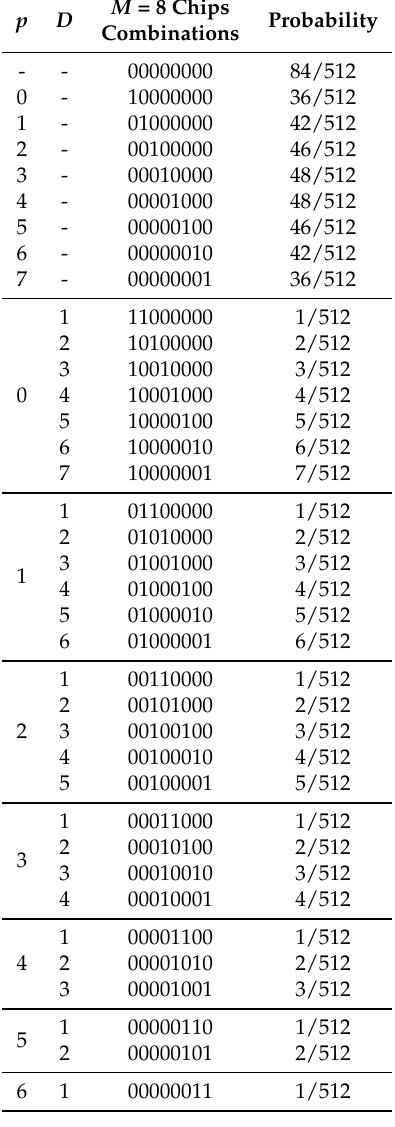
Table 3. Probabilites of M = 8 asynchronous